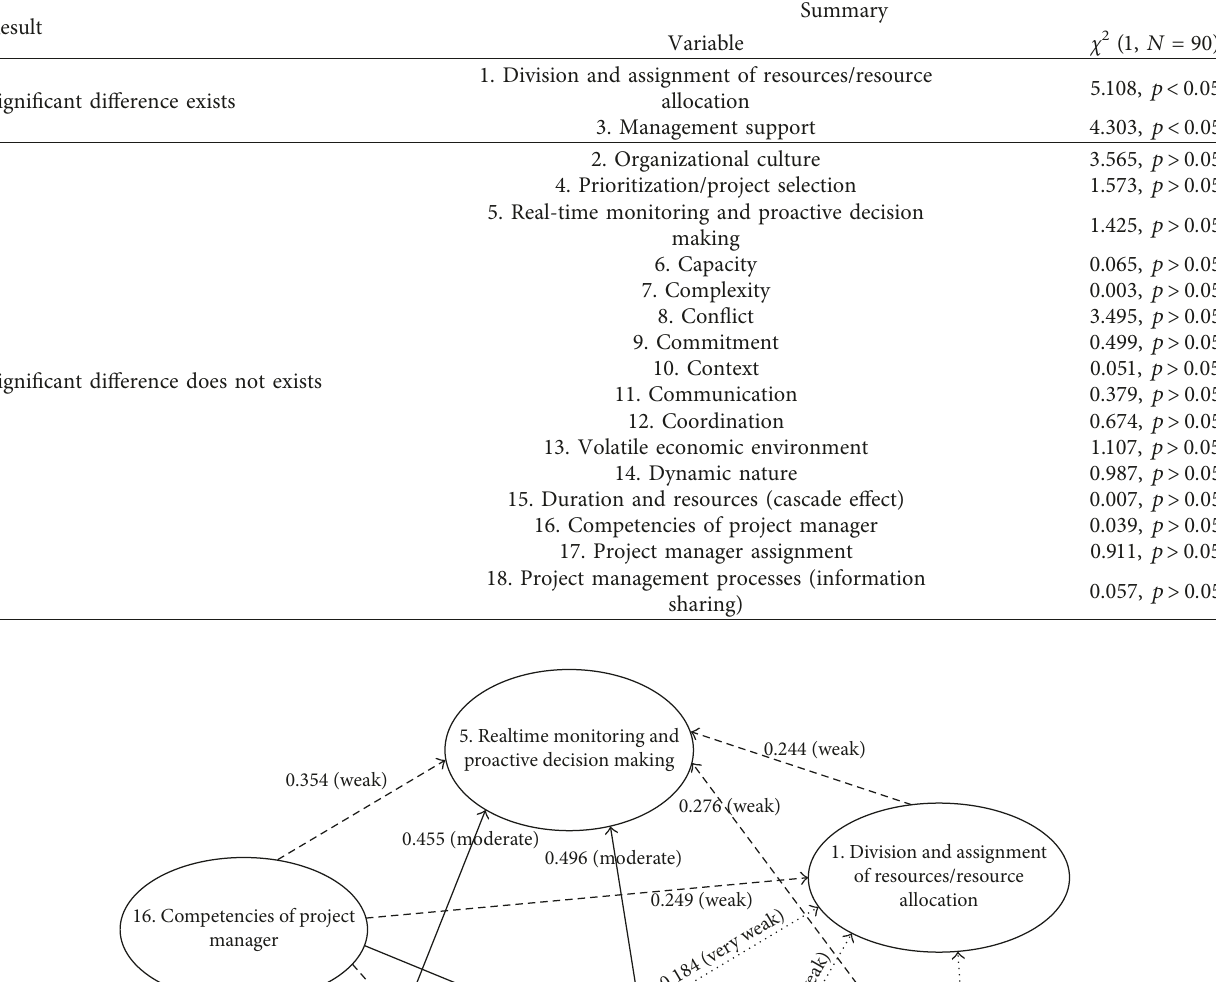
Table 4: Kruskal–Wallis test for checking the differences between client-side and contractor-side.